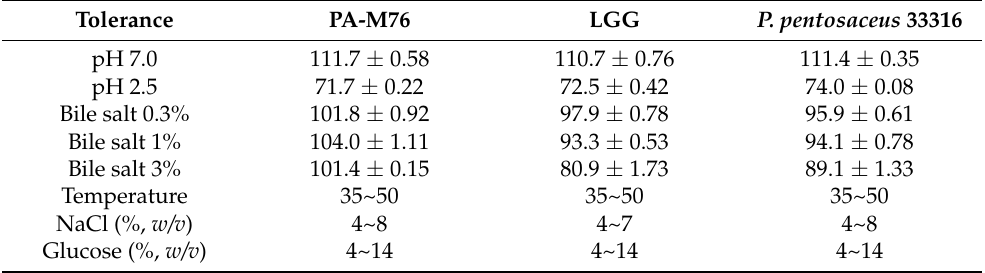
Table 1. Physiological and biochemical properties of Pediococcus acidilactici M76.